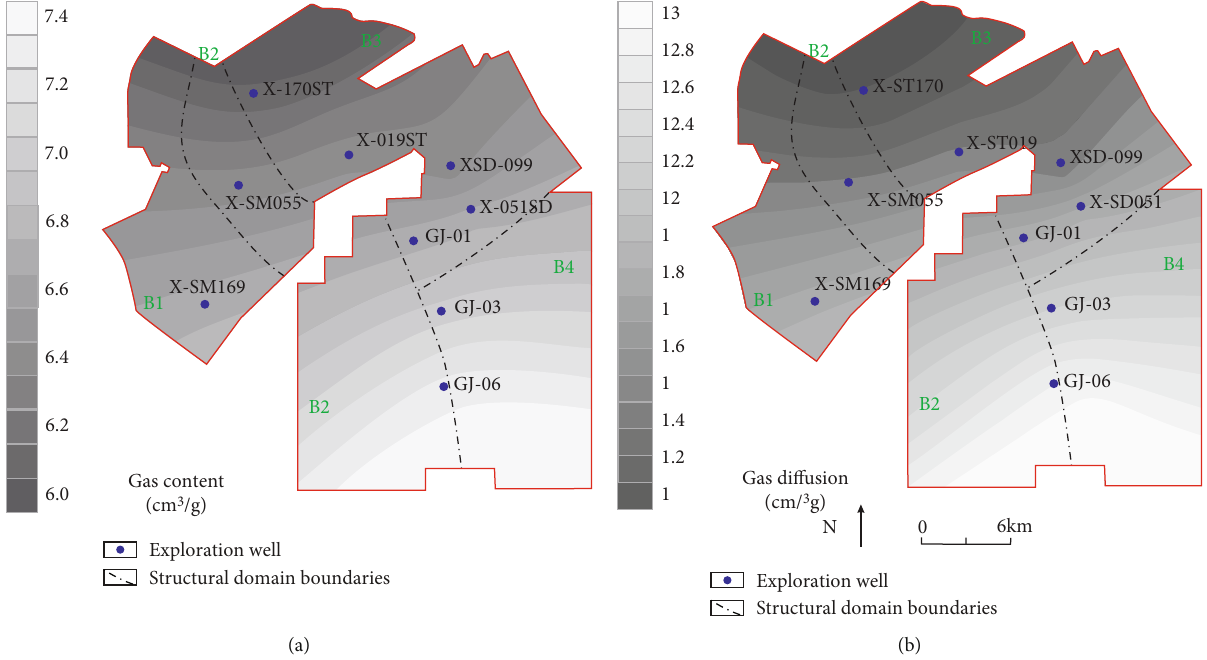
Figure 10: Distribution characteristics of gas content (a) at the end of Middle Triassic period and gas di ff usion during the Indosinian orogeny